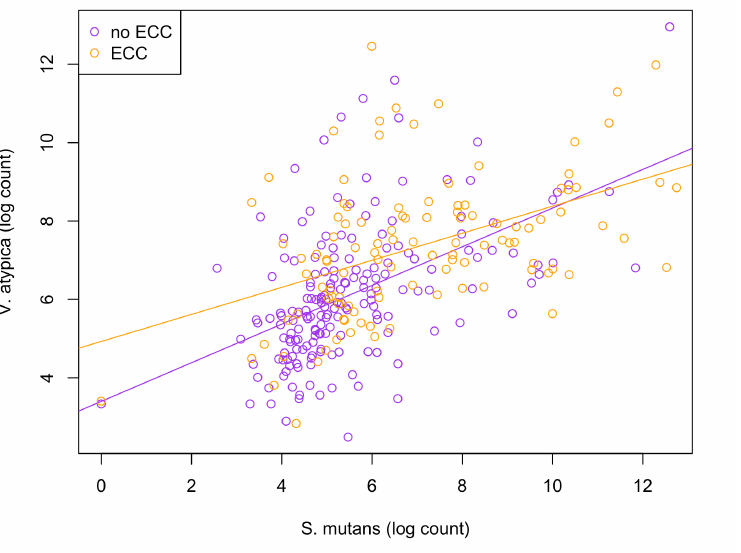
Figure 6. Scatterplot illustrating the comparison of relationships between S. mutans and V. atypica abundances between healthy (non-ECC) and disease (ECC)